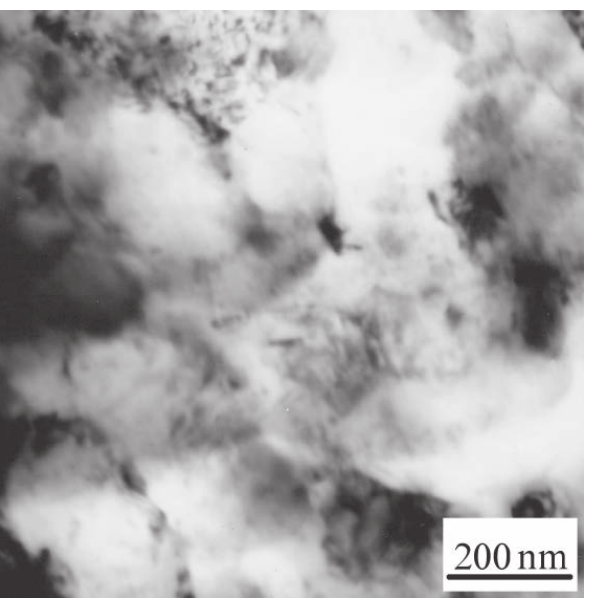
Fig. 21: Dependence of the minimum deflection rate on the applied force